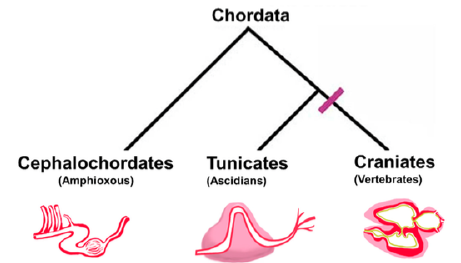
Fig. 2: Figure illustrating the phylogenetic rela- tionship and general heart structure of the Chor- date subphyla. Cephalochordates, like amphioxus, have a series of four peristaltic vessels that serve as a pump, while tunicates have a single-chamber pump, which is composed of a single layer of myocardium (red) surrounded by stiff pericar- dial layer (pink). The earliest vertebrates, e.g., lampreys, have at least a two-chambered heart composed of a layer of cardiac myocardial cells (red), an endocardial cellular layer (yellow), valves that separate distinct chambers, and a surrounding pericardium (pink). Figure adapted from [16].